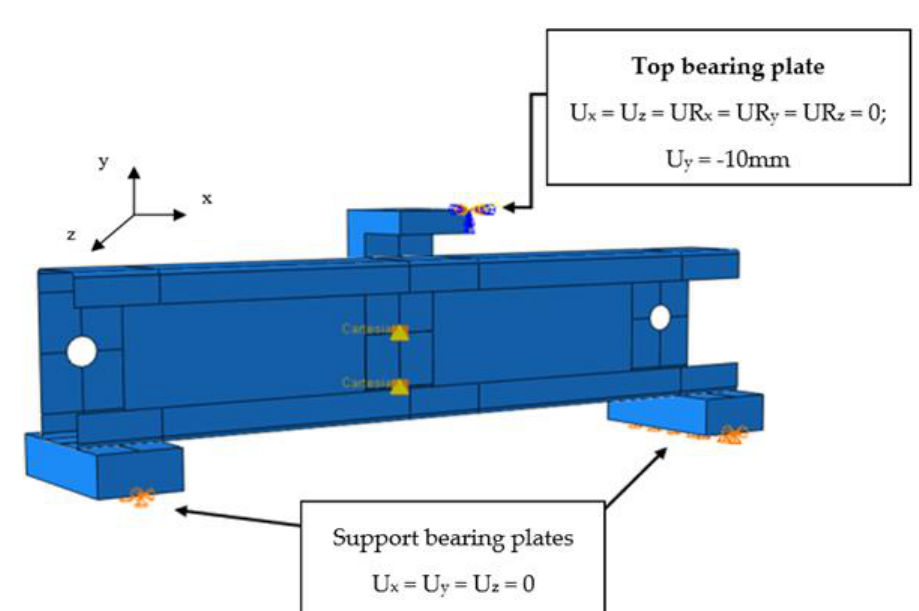
Figure 8. Boundary conditions used in FE models.